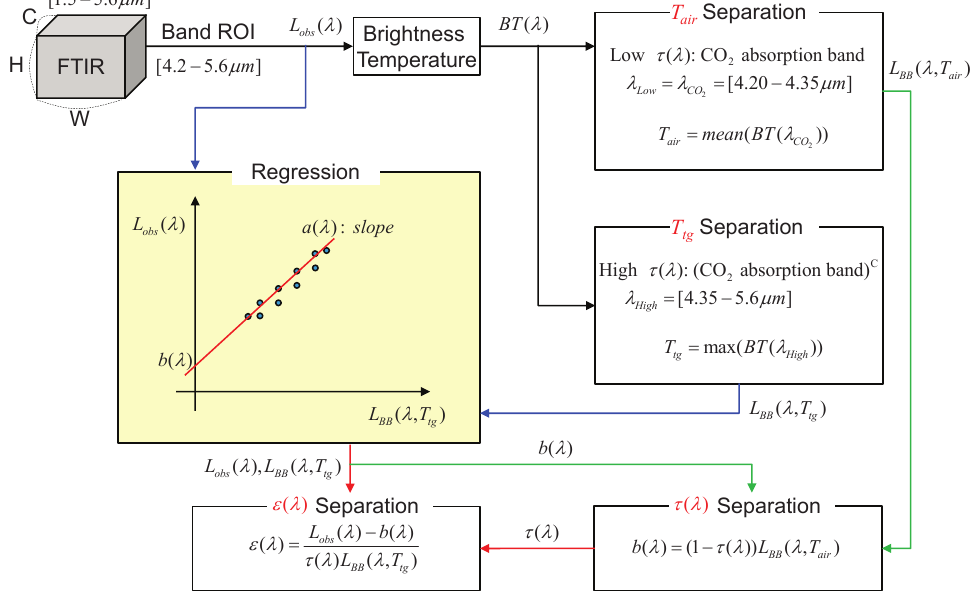
Figure 5. Proposed simultaneous AT 2 ES